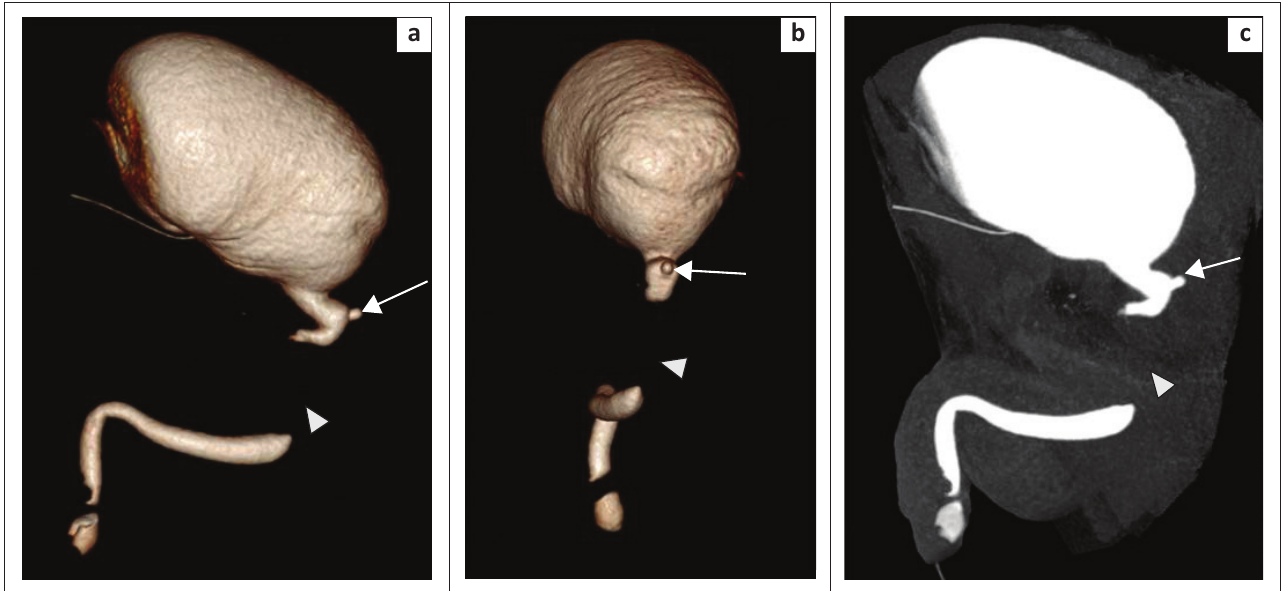
FIG URE 10: (a, b) Volume rendered technique images (multidetector computed tomographic urethrography) showing a posterior urethral distraction defect (arrowhead) and a urethral diverticulum (arrow) in different planes. (c) Maximum intensity projection image of the same patient showing the posterior urethral distraction defect (arrowhead) and urethral diverticulum (arrow) clearly.